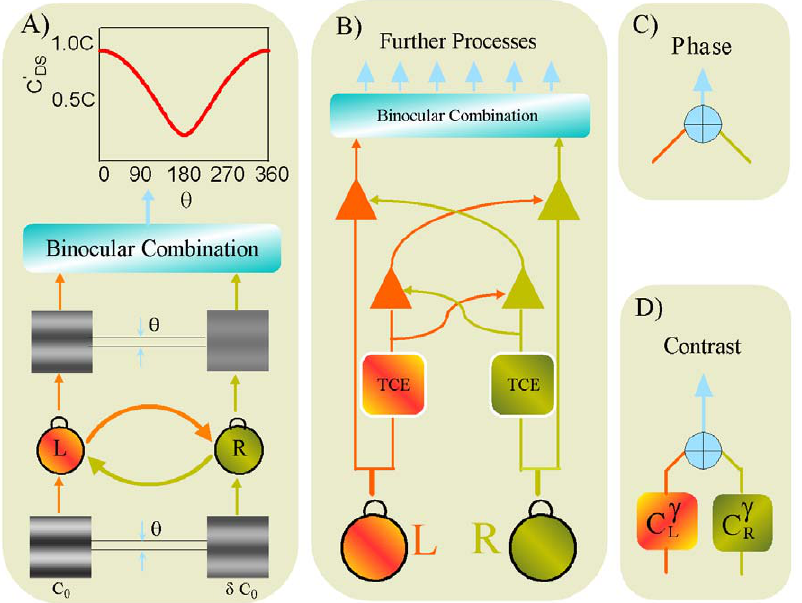
Figure 4. Multi-pathway contrast-gain control model (MCM) of binocular combination. (A) Perceived contrast of the cyclopean images predicted by phase-dependent contrast binocular combination models (e.g., the Ding-Sperling model). (B,C,D) Schematic diagram of the multi- pathway contrast-gain control model (MCM) of binocular combination. Signals first go through double interocular contrast gain control (B), in which each eye exerts gain control on the other eye’s signal in proportion to its own signal contrast energy, and also gain-controls over the other eye’s gain control. The multi-pathway contrast-gain control model (MCM) of binocular combination elaborates the Ding-Sperling binocular combination model in two ways: (1) Phase and contrast of the cyclopean images are computed in separate pathways (C and D), although with shared cross-eye contrast- gain control; and (2) phase-independent local energy from the two monocular images are used in contrast combination.